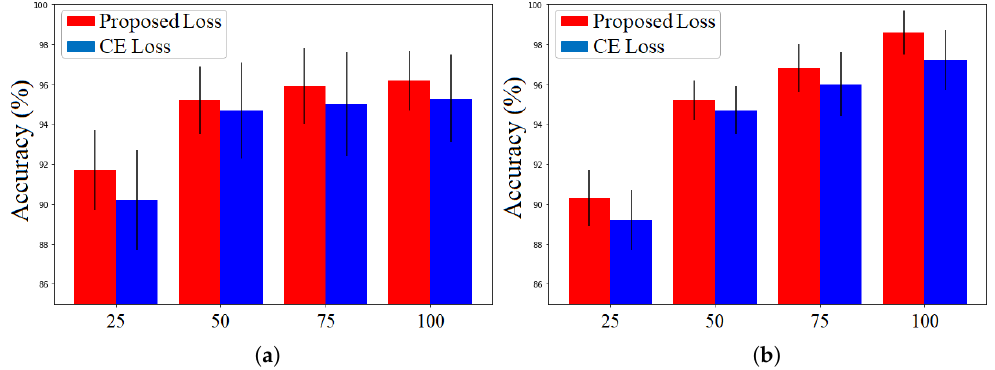
Figure 10. Comparison of the classification accuracies after 25th, 50th, 75th, and 100th epochs achieved by the proposed CNN model when trained with proposed loss and CE loss on the prepared dataset. Error bars illustrate ±1 standard deviation ( a ) results on the RGB image dataset; ( b ) results on the laser image dataset.